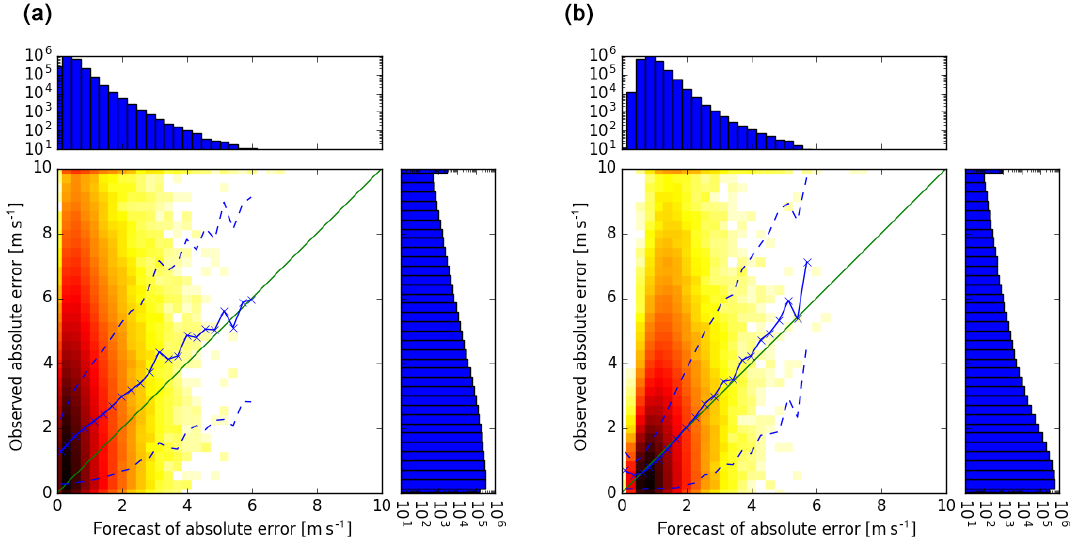
Figure 9. Scatter plots of 3h forecasts of the absolute errors of COSMO-DE-EPS forecasts of wind gust speeds (estimated as ensemble standard deviations × 0 . 8) versus observed absolute errors of the ensemble means (a) and corresponding 1h error forecasts of Ensemble- MOS versus observed absolute errors of Ensemble-MOS (statistical fit of training period, b ). Means of observed absolute errors (solid) and confidence intervals (means ± standard deviations, dashed) are shown. Six years of data (2011–2016) are